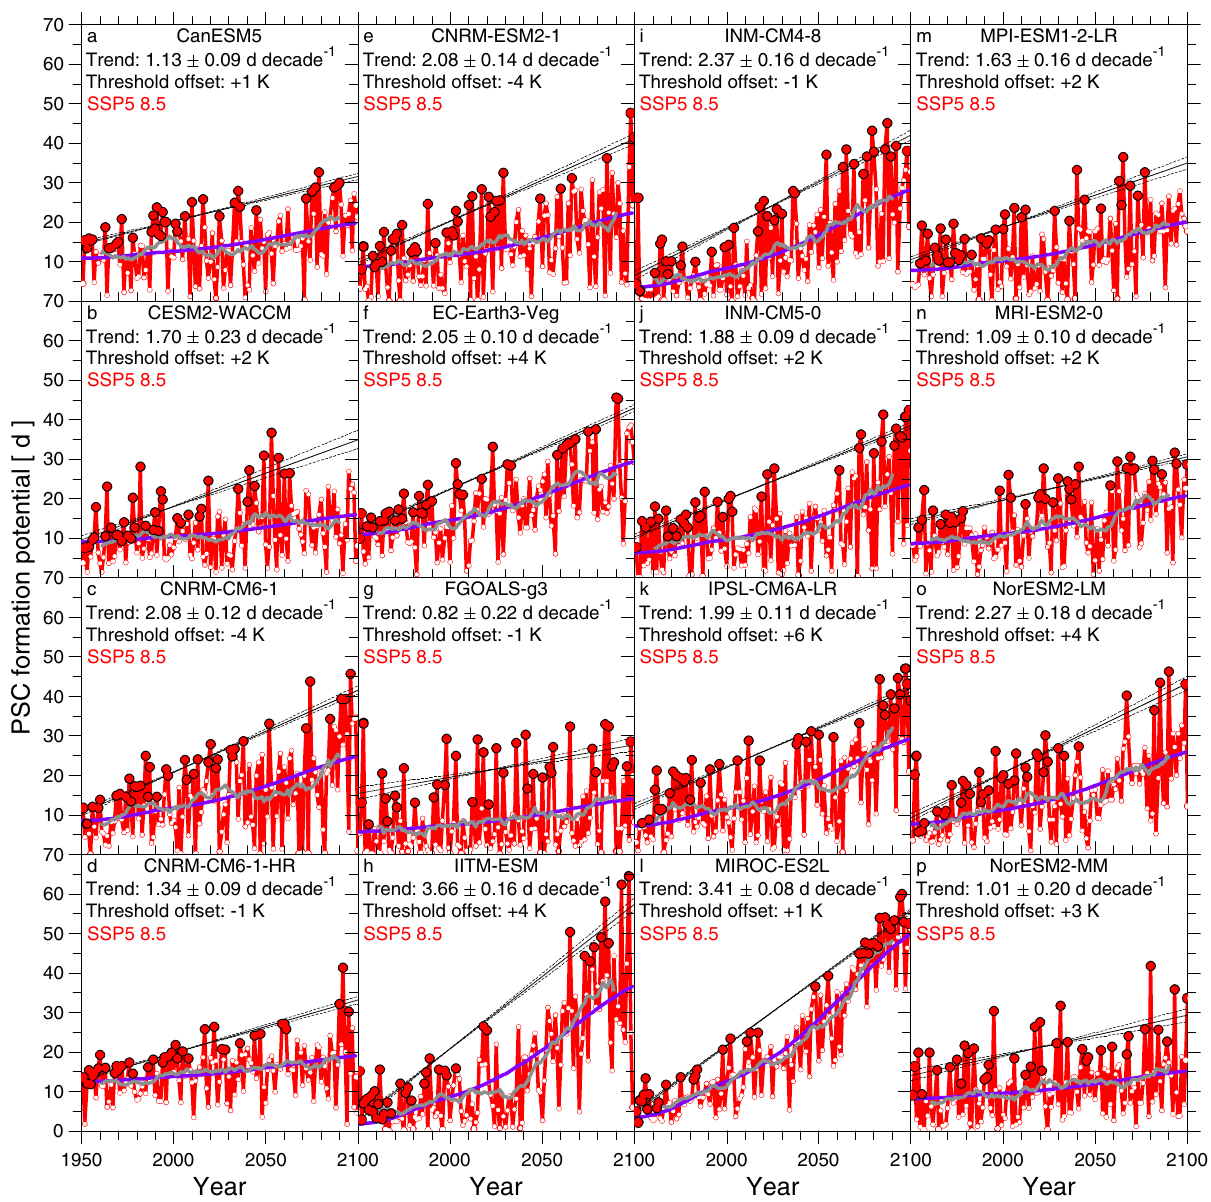
Fig. 4 PFP, 1950 – 2100, from CMIP6 GCMs for SSP5-8.5 scenario and time-invariant H 2 O. a – p Time series of PSC formation potential (PFP) from 16 CMIP6 GCMs (as indicated on top of each panel), based on archived output from the SSP5-8.5 scenario (2015 – 2100) combined with output from the historical scenario (1950 – 2014). The solid circles indicate the coldest winters in the record (local maxima) selected using the ISA trend detection procedure (see “ Methods ” ). A linear, least-squares fi t (solid line) and 1 σ uncertainty (dashed lines) to the solid red circles are shown in each panel, along with numerical values of the slopes ( S PFP − LM ) and 1 σ uncertainties of these fi ts. The blue line shows the best fi t to PFP of the radiative forcing time series for each model run, and the grey line is a 21-year running mean (±10 years) to PFP from each GCM. The temperature threshold for the formation of PSCs has been offset by a constant number, speci fi c to each model, so that the overall magnitude of PFP LM in the GCM matches the observed magnitude of PFP LM , over the modern satellite era (see “ Methods ” and Table